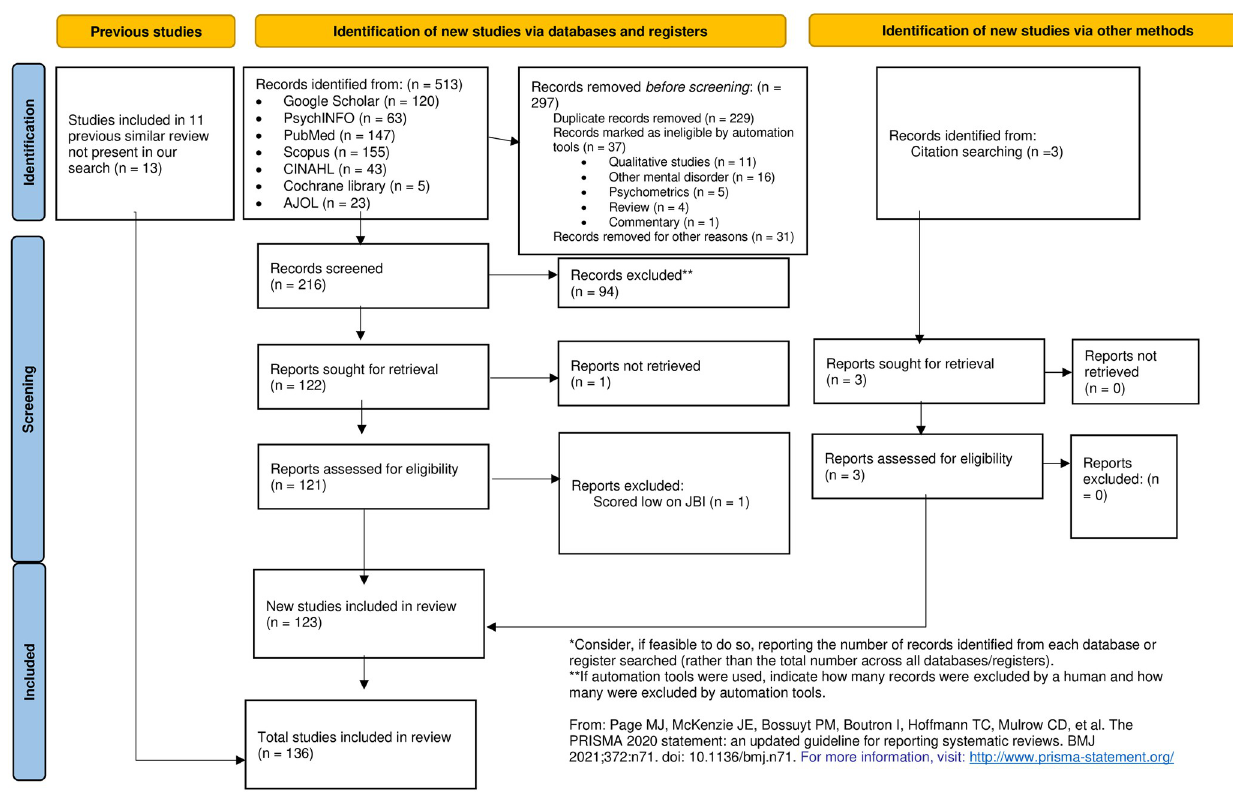
Fig 1. The PRISMA flow